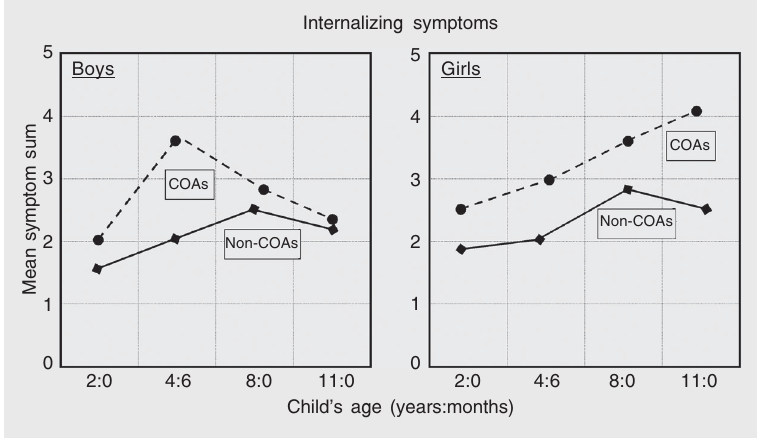
Figure 3. Longitudinal effect of paternal alcoholism on the development of internalizing symptoms in males and females. COAs = children of alcoholic fathers; non-COAs = children of non-alcoholic